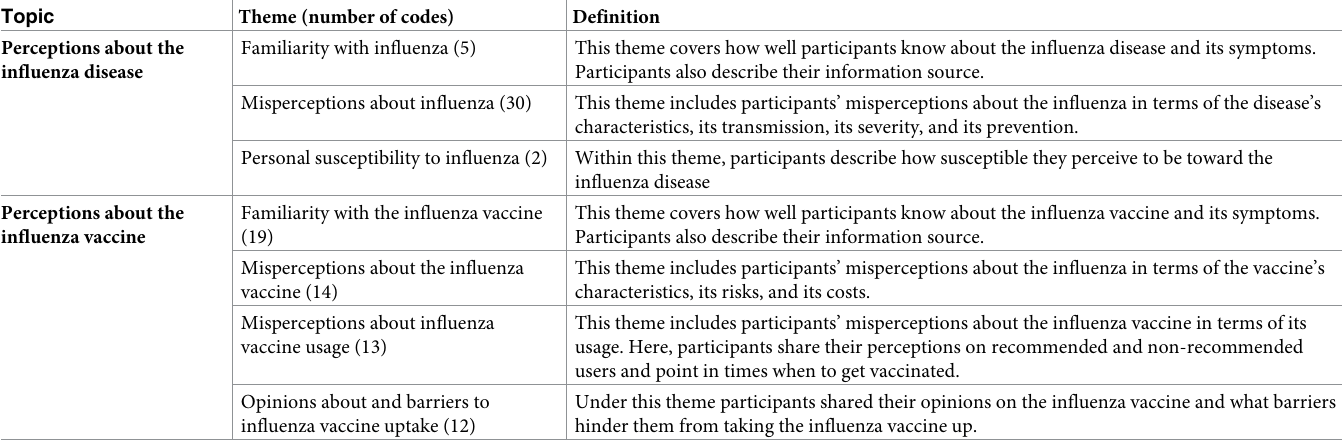
Table 2. Typology of influenza disease and influenza vaccine